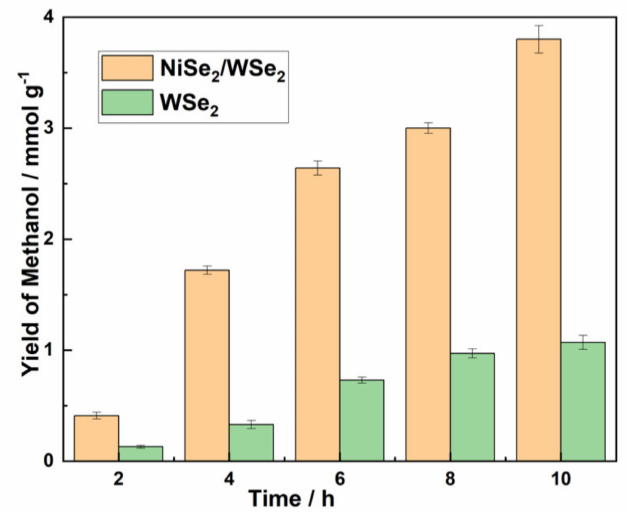
Figure 9. Relationship between the yield of methanol and the reaction time.